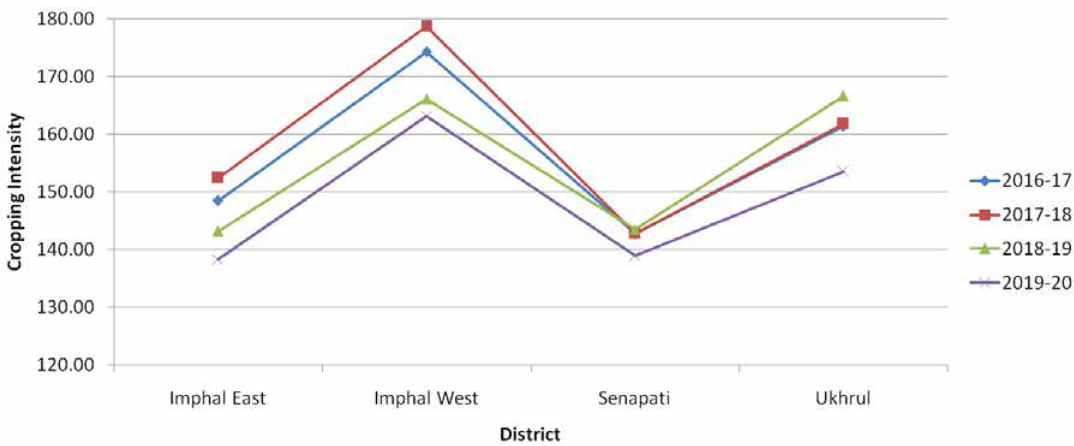
Fig. 6: Cropping intensity of each district lying under Imphal-Iril River catchment (DOA,